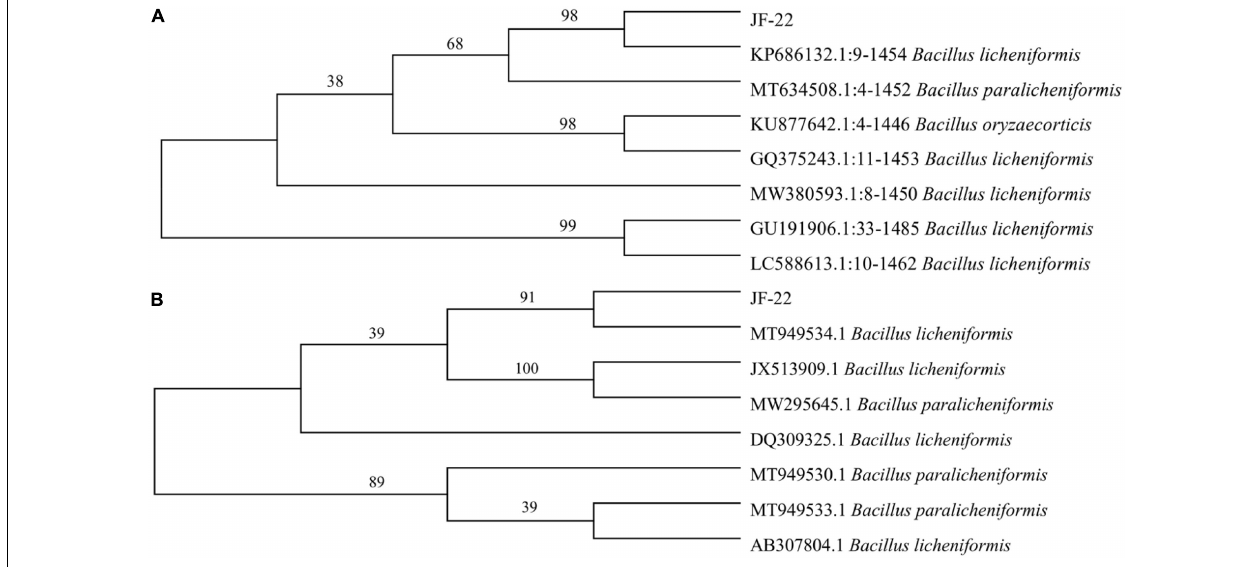
FIGURE 1 | Phylogenetic tree shows relationship between JF-22 and other strains. (A) Phylogenetic tree constructed based on 16S rDNA sequences of strain JF-22 and 7 other Bacillus strains; (B) Phylogenetic tree constructed based on gyrB gene sequences of strain JF-22 and 7 other Bacillus strains. Bootstrap values (%) presented at the branches were calculated from 1,000